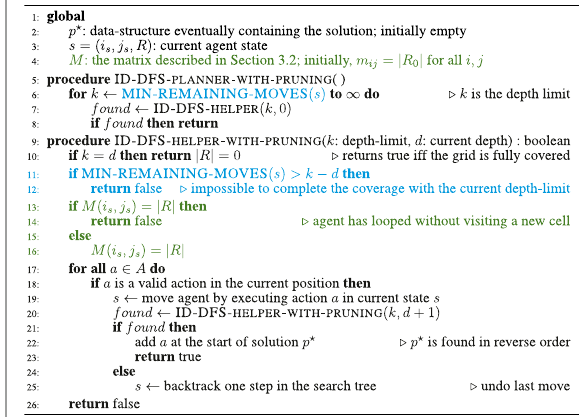
Algorithm3. Heuristiccostcomputation.